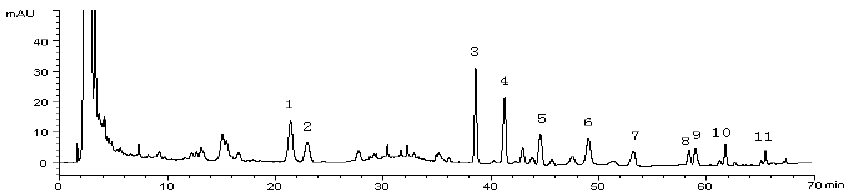
Figure 2. Typical HPLC chromatogram of a fresh ginseng root. Peak numbers: 1—Rg 1 ; 2—Re; 3—Ro;